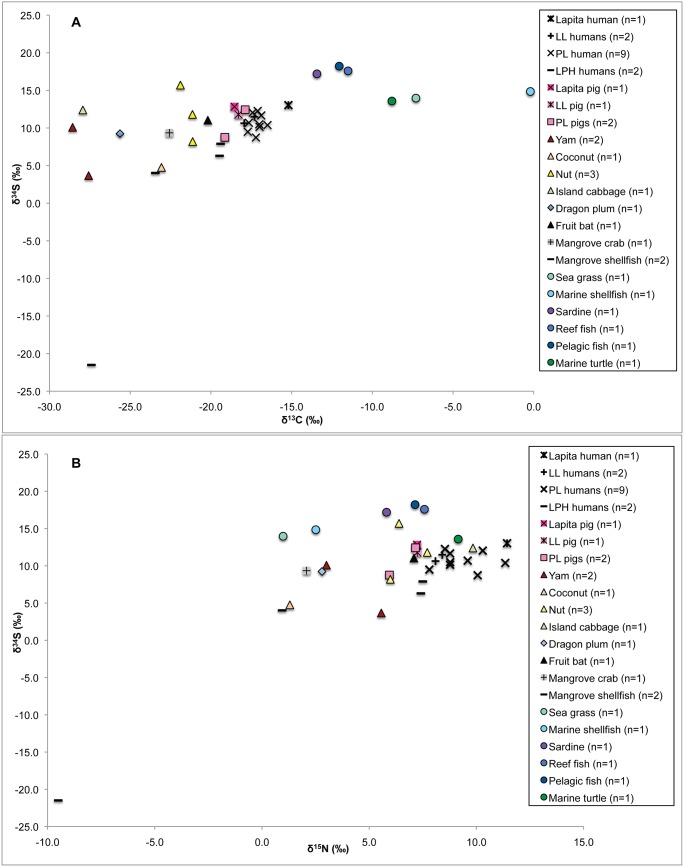
Uripiv human and pig δ13C and δ34S (A) and δ15N and δ34S (B) values.Human values plotted in relation to modern plant and animals from Vanuatu. Note that the modern δ13C values have been corrected for the Suess effect.